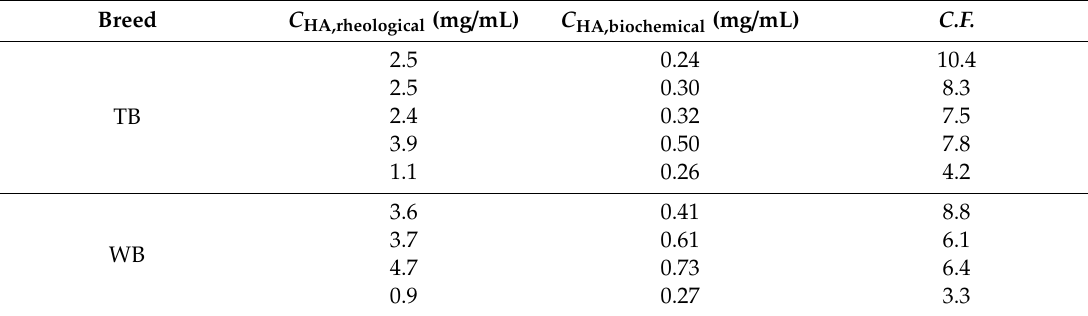
Table 5. HA concentration in SF from pathological equine fetlock joints, as calculated either based on SF rheology or by employing the biochemical ELISA